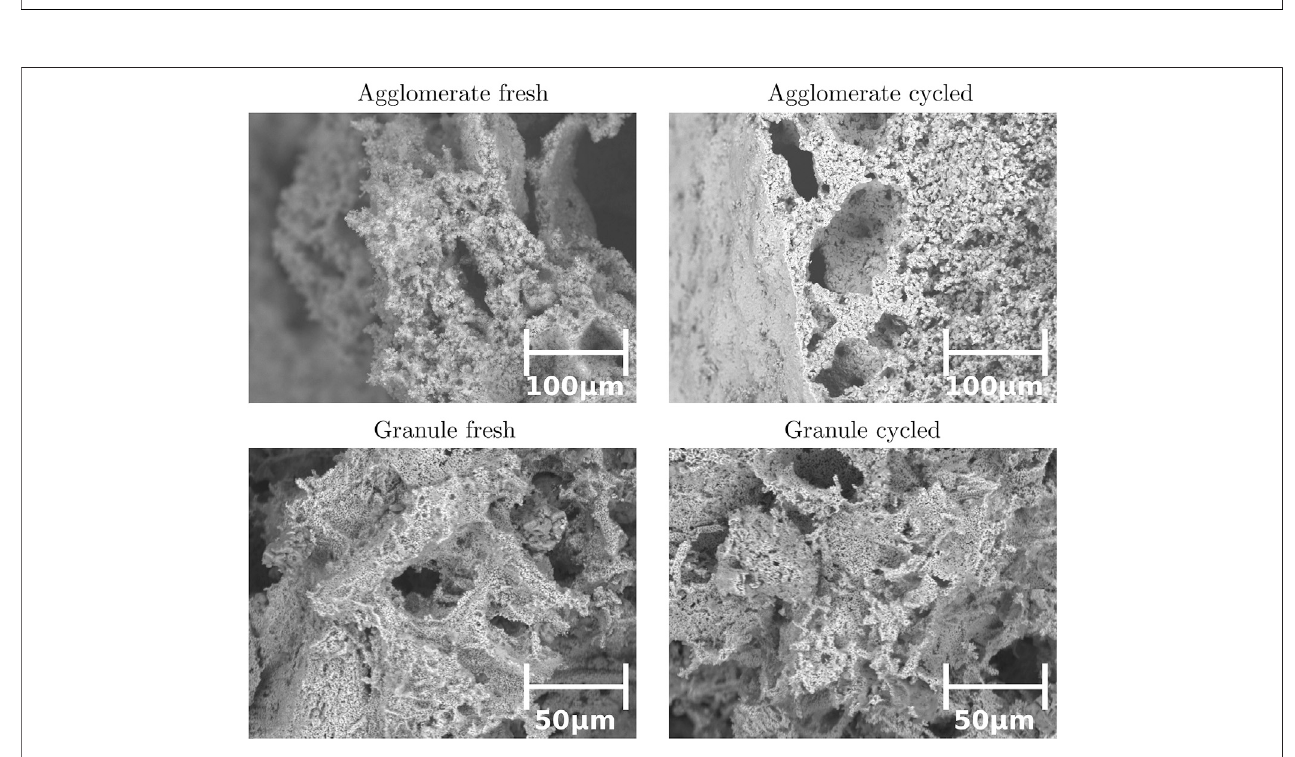
FIGURE 4 | SEM images of agglomerate before (top left) and after cycling ( top right) , and granules before (bottom left) and after cycling (bottom right) .